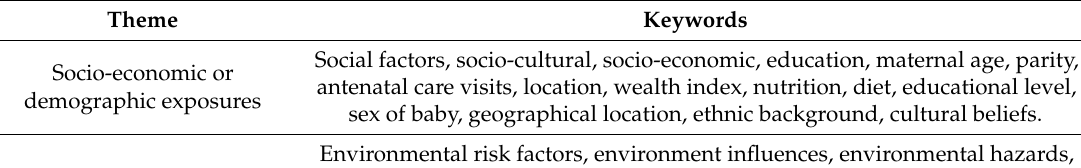
Table 1. Sample of the search terms